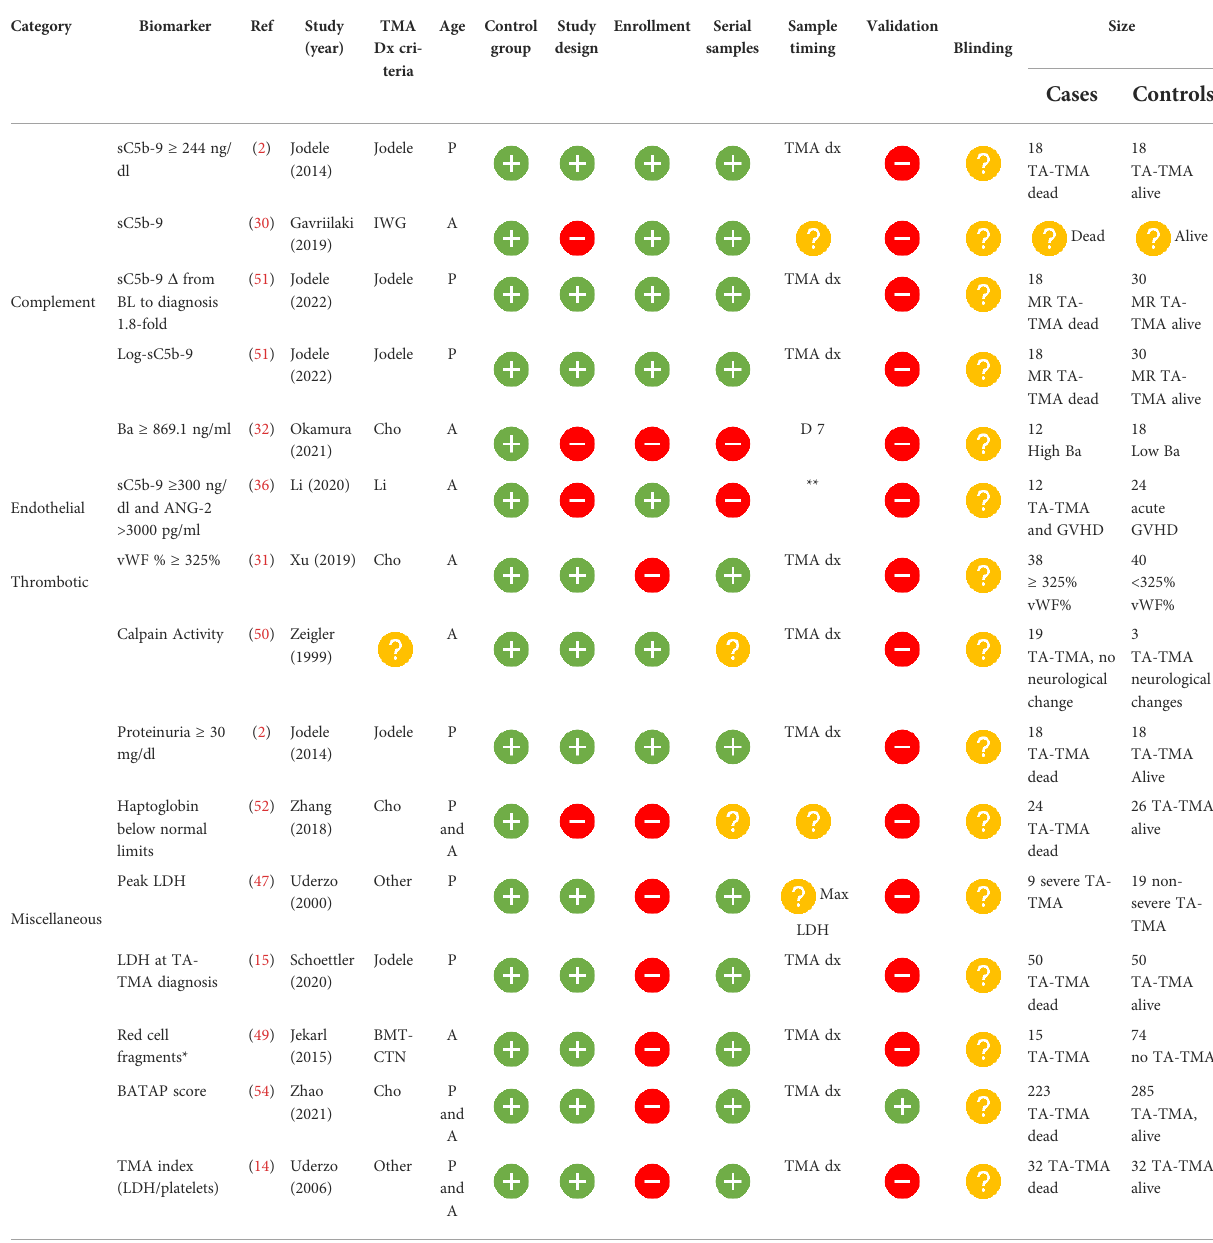
TABLE 5 b -group prognostic